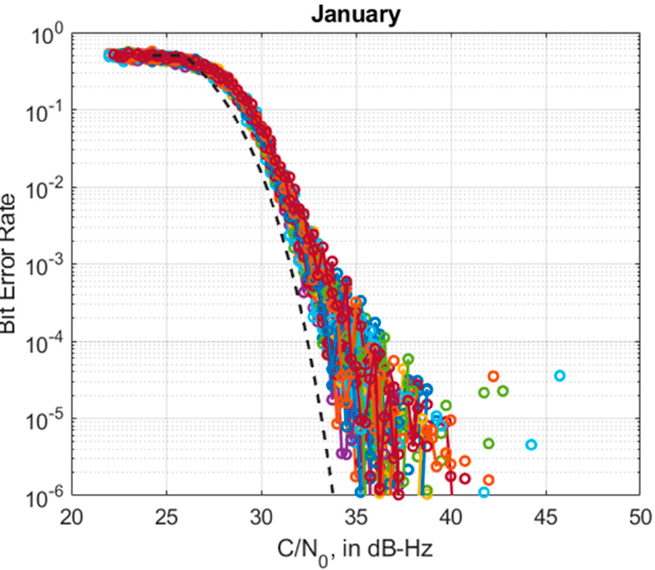
Figure 5. Daily BER versus C / N 0 for the month of January 2021. The dashed black line represents the theoretical BER curve assuming Gaussian noise. Different colors refer to different days of the month.